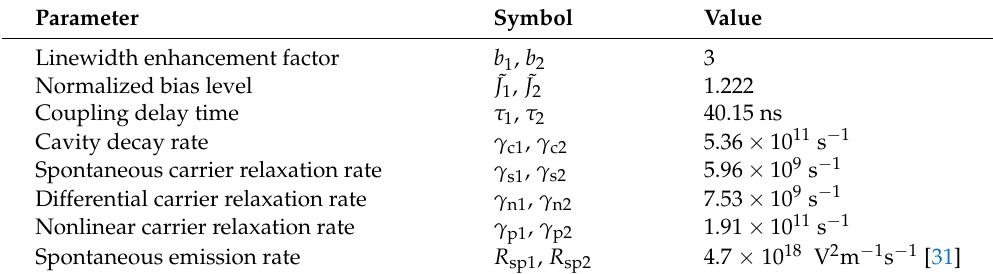
Table 1. The values of laser parameters used in the numerical calculation. Parameter Symbol Value Linewidth enhancement factor b 1 , b 2 Normalized bias level Coupling delay time Cavity decay